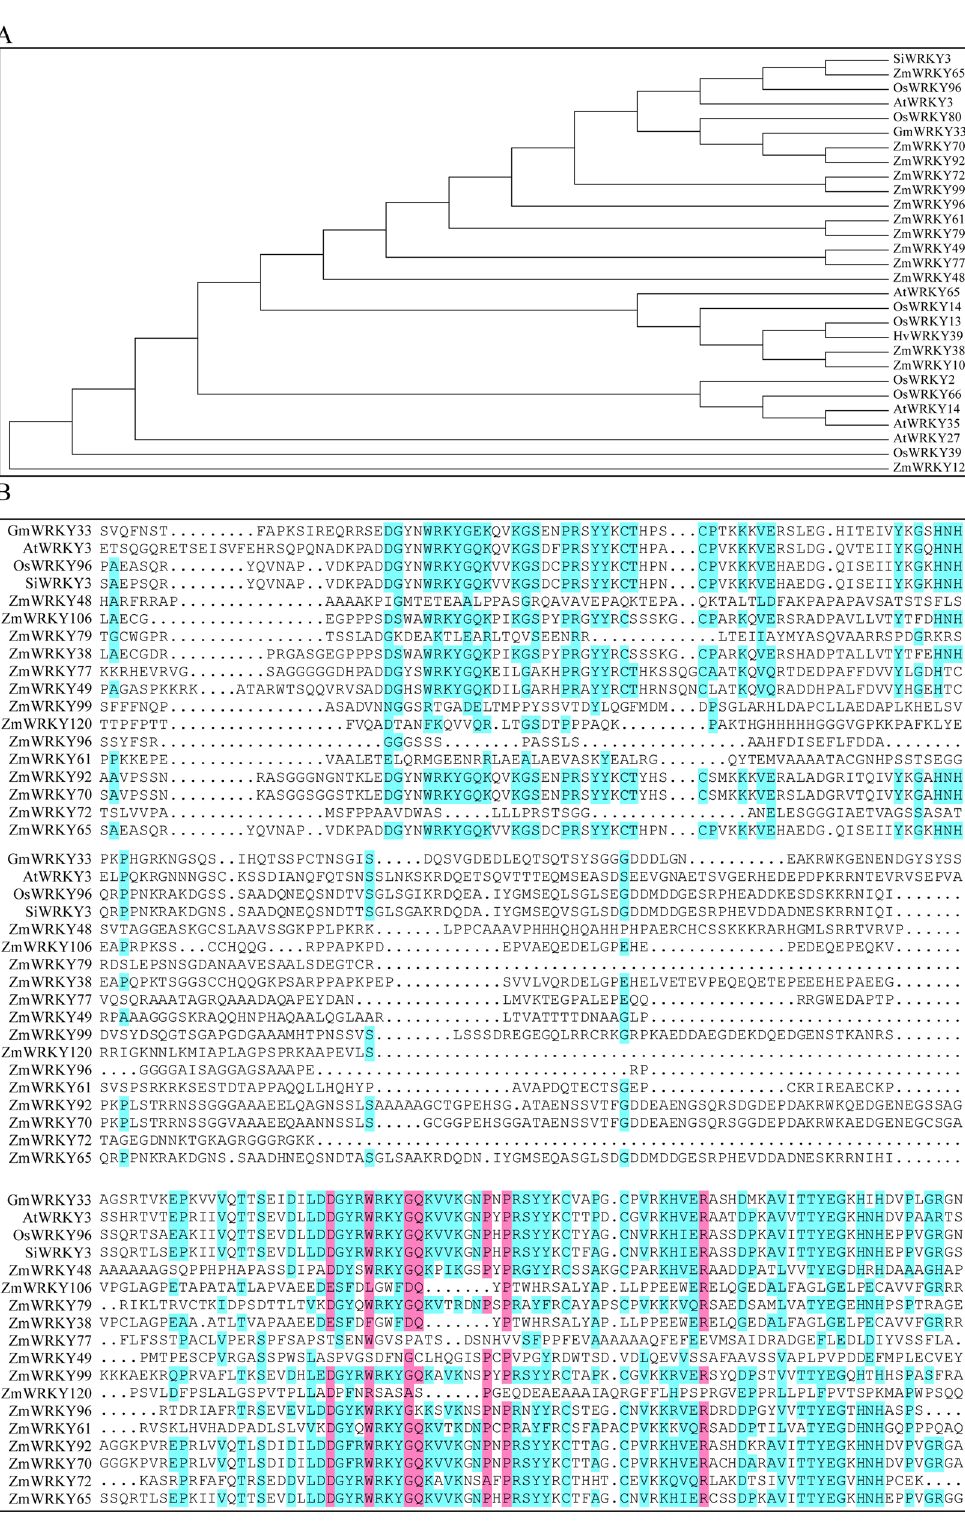
Figure 2. Analyses of sequence alignments and phylogenetic tree. ( A ) Phylogenetic analysis of ZmWRKY65 in relation to closely related WRKY proteins. ( B ) Alignment of the putative amino acid sequence of ZmWRKY65 with sequences from Arabidopsis , rice, millet, barley and